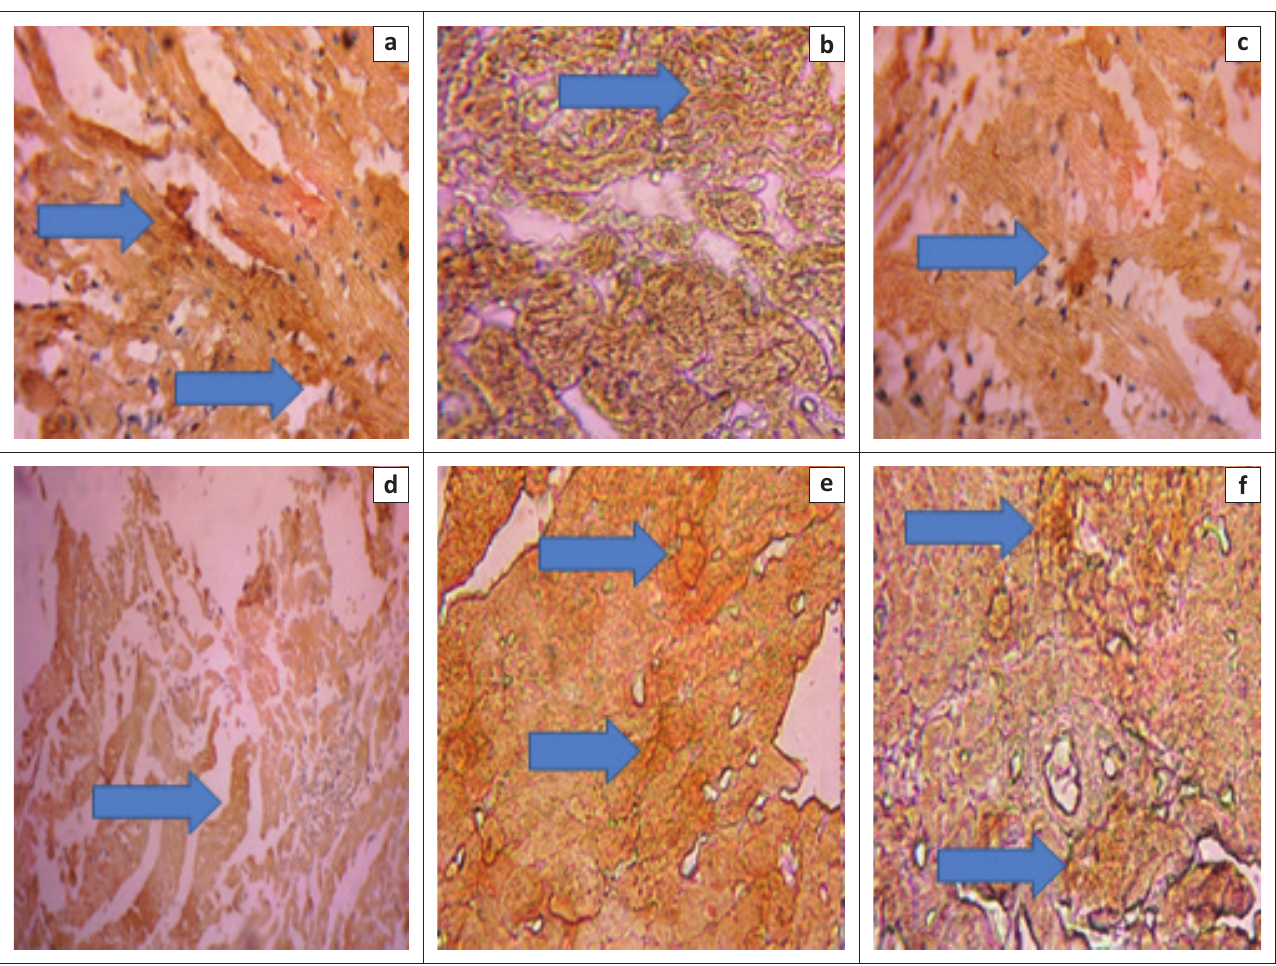
FIGURE 15: Immunohistochemistry of C-reactive protein in heart of isoproterenol-induced myocardial infarction